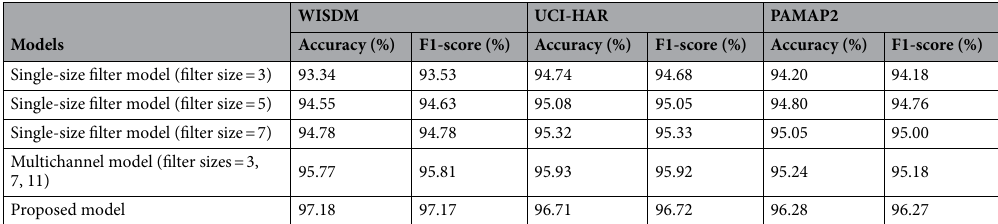
Table 10. Performance comparison of the proposed model with different filter